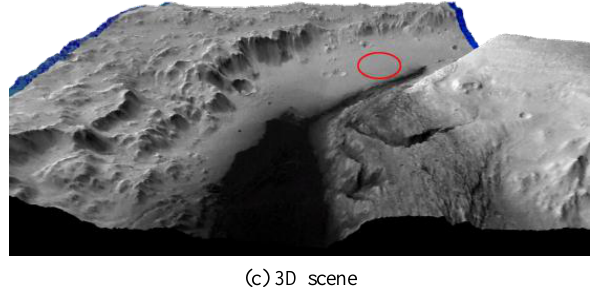
Figure 8. DEM results of H5273 compared with ESA